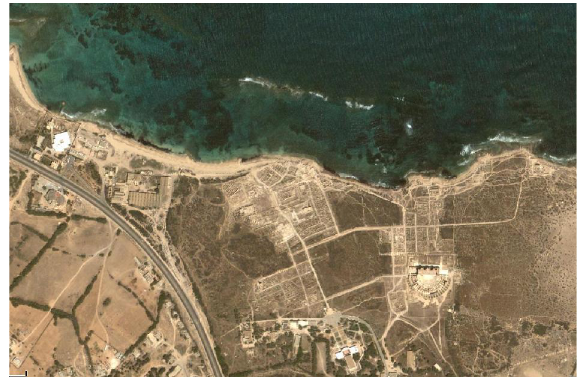
Figure 1. View of the coast of Sabratha